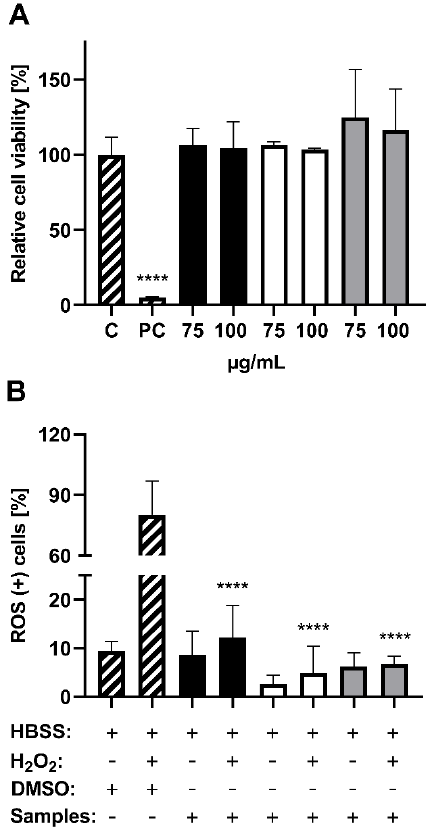
Figure 5. Exclusion of cytotoxic effects as well as the detection of a reactive oxygen species (ROS) reducing potential of lingonberry XAD-7 extract (full black color), anthocyanin fraction (full white color), and copigment fraction (full grey color) using HepG2 cells. Shown is the mean ± standard deviation; n = 3. ( A ) MTT assay; C: 0.1% DMSO as solvent control; PC: 1% Triton X as positive control. Statistically significant differences (**** p < 0.0001) compared to solvent control cells. ( B ) ROS reducing effects of lingonberry samples (100 µg/mL) or 0.1% DMSO followed by incubation with or without H 2 O 2 (100 µM) all dissolved in HBSS. Significance detection: H 2 O 2 treated or nontreated sample free control (striped color) were compared to samples with or without H 2 O 2 post-treatment. **** p < 0.0001.